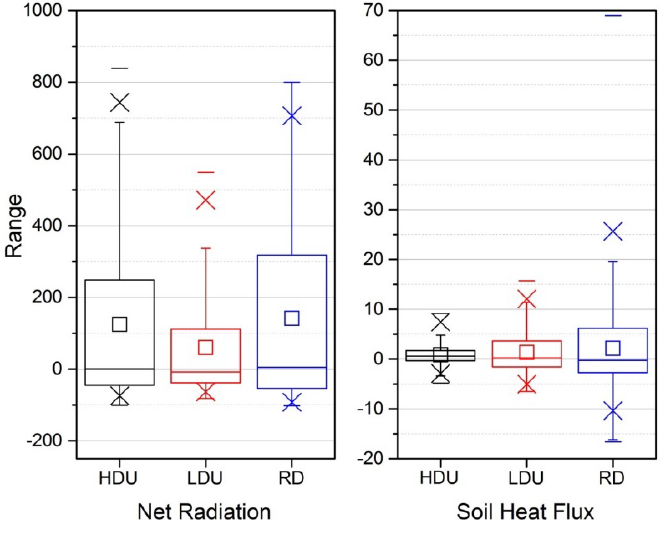
Figure 9. Descriptives of net radiation and soil heat flux at low density urban (LDU), recent development (RD), and high density urban (HDU) gradient monitoring sites from 2 June 2013 to 28 September 2013, Columbia, Missouri, USA. Range units = W/m 2